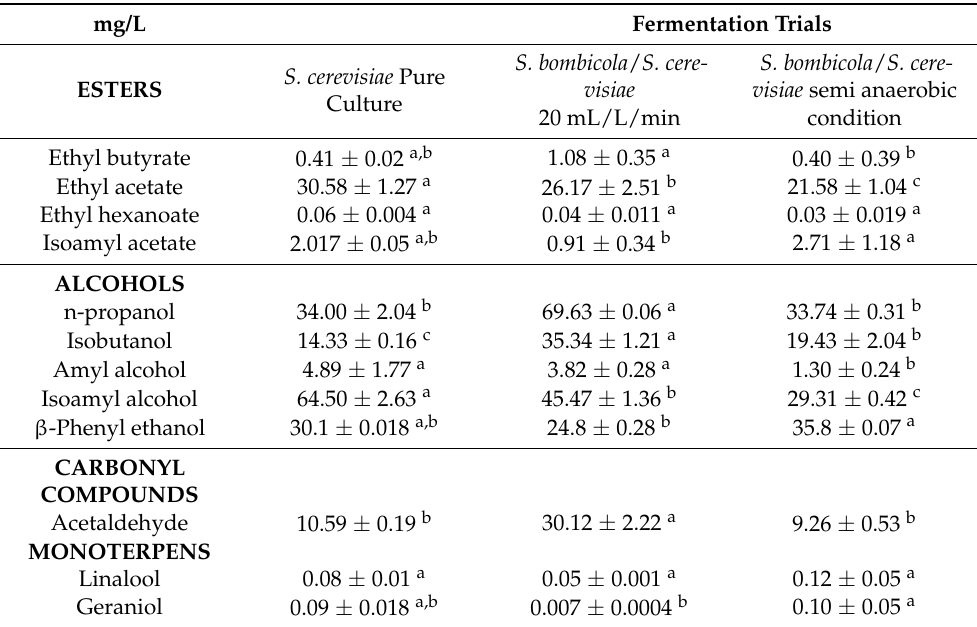
Table 2. The main volatile compounds of S. cerevisiae pure culture and sequential fermentations with or without air flow addition. Data are means ± standard deviations from three independent experiments. Data with different superscript letters ( a,b,c ) within each Column are different according to Duncan tests